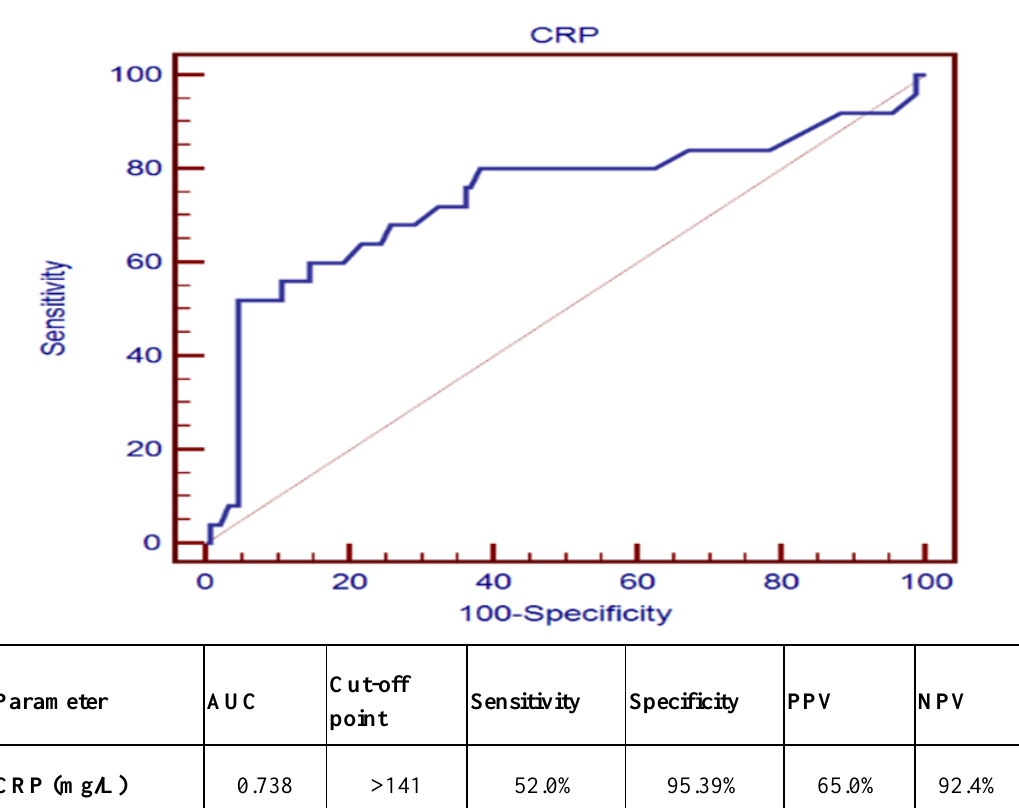
Figure 1. ROC curve of CRP level as a predictor of COVID-19 severity between mild to moderate and severe